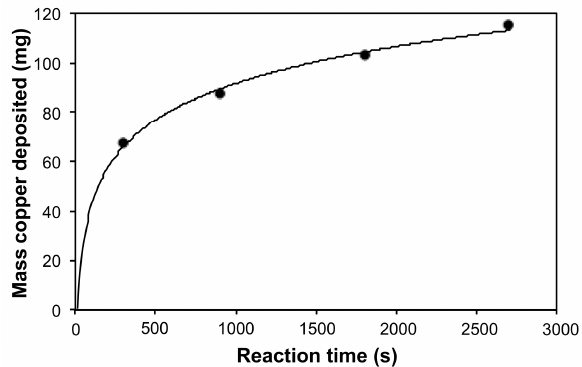
Figure 1. Plot of copper mass (mg) in the resulting Cu-SWCNT composites grown by electroless deposition as a function of reaction time (s) ( R 2 = 0.99).